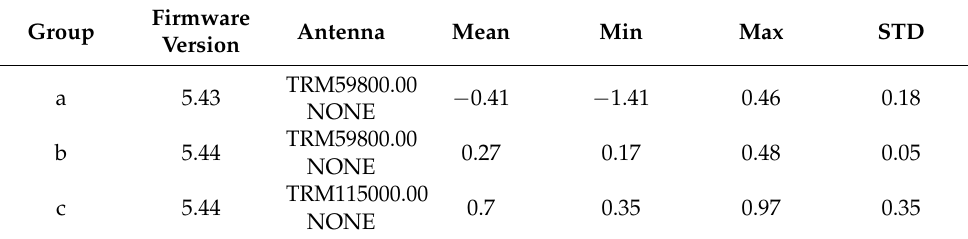
Figure 15. STDs of receiver C2I–C6I DCB estimates at each station. The stations are aligned by geographic latitude on the horizontal axis.